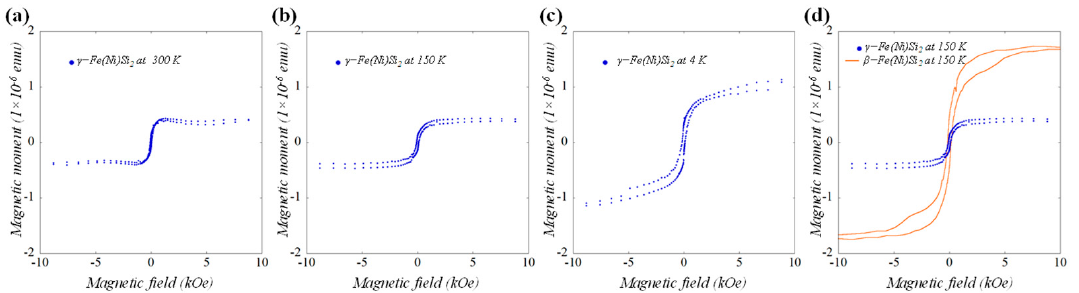
Figure 4. In-plane magnetization reversal loop of grown assembly of γ -Fe(Ni)Si 2 NSs measured at ( a ) 300 K, ( b ) 150 K and ( c ) 4 K. Observed loop at 150 K for γ phase is compared with β phase in ( d ). The displayed magnetic moments have been normalized to reflect the twice larger volume of the as-deposited Py film in the γ -sample in comparison with that used to produce the β -sample in ( d ).